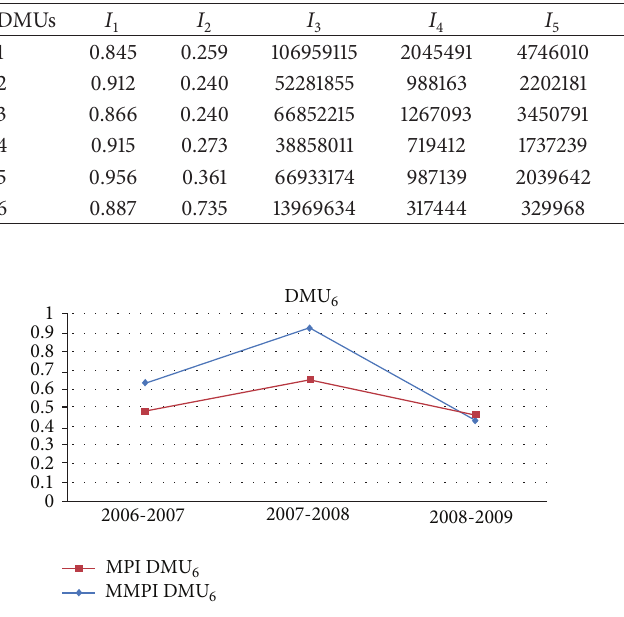
Figure 4: Malmquist changes for DMU 6